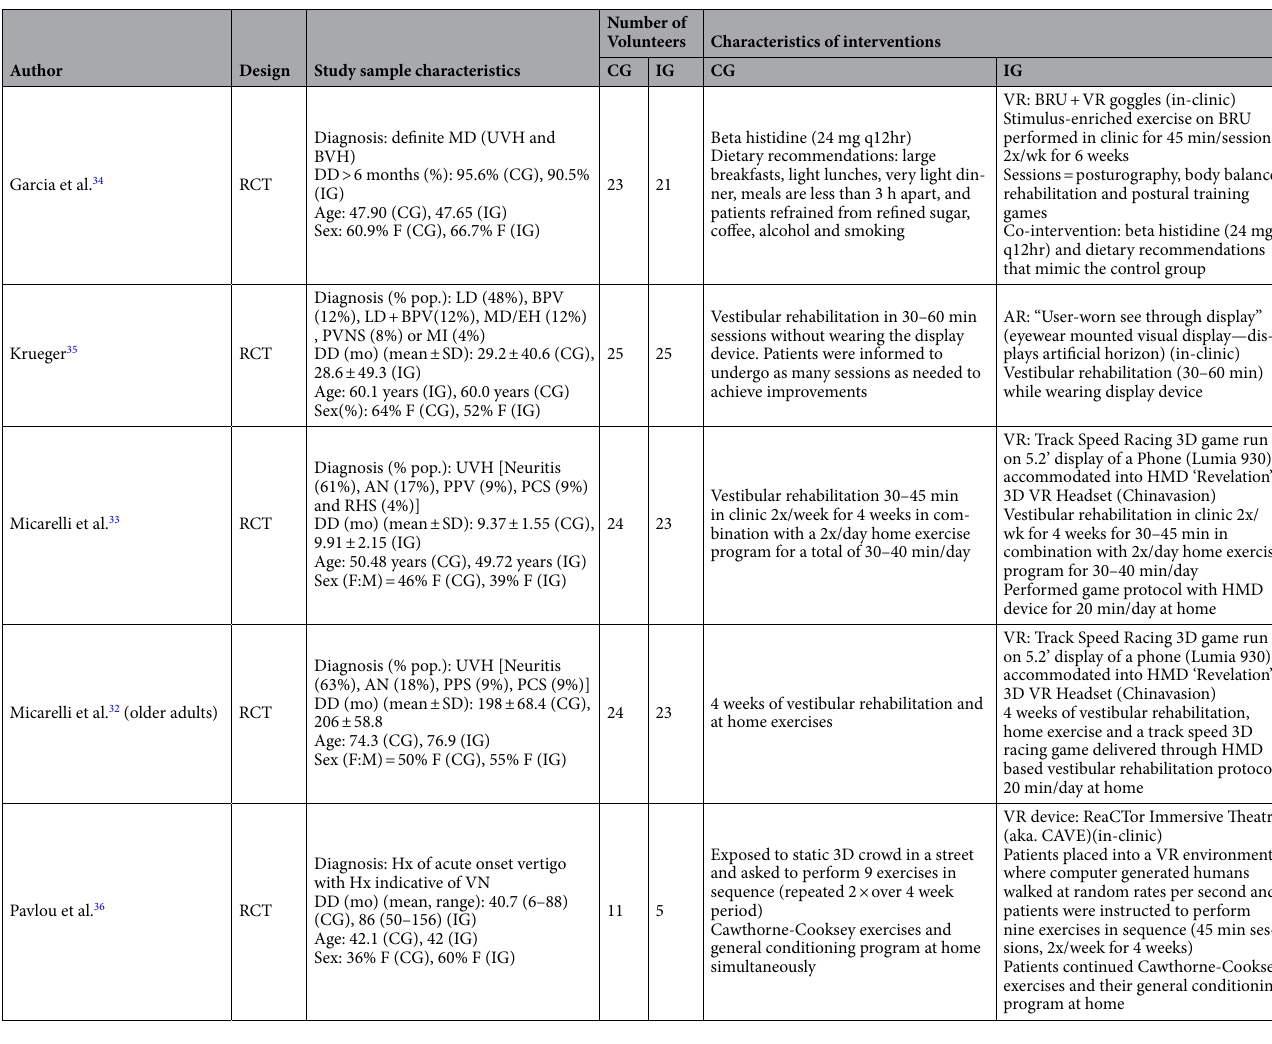
Table 1. Characteristics of the virtual or augmented reality protocol and study sample used in the included randomized controlled trials. AN acoustic neuroma, AR augmented reality, BPV benign positional vertigo, BRU balance rehabilitation unit, BVH bilateral vestibular hypofunction, CG control group, DD disease duration, EH endolymphatic hydrops, F female, HMD head mounted display, Hx history, IG intervention group, LD labyrinth dysfunction, M male, MD Menieres disease, MI motion intolerance, PCS previous cochlear surgery, PPS previous petrous surgery, PVNS previous vestibular nerve section, RCT randomized controlled trial, RHS : Ramsay Hunt syndrome, Sx symptoms, UVH unilateral vestibular hypofunction, VN vestibular neuritis, VR virtual reality, 3D three dimensions, % pop percentage of study